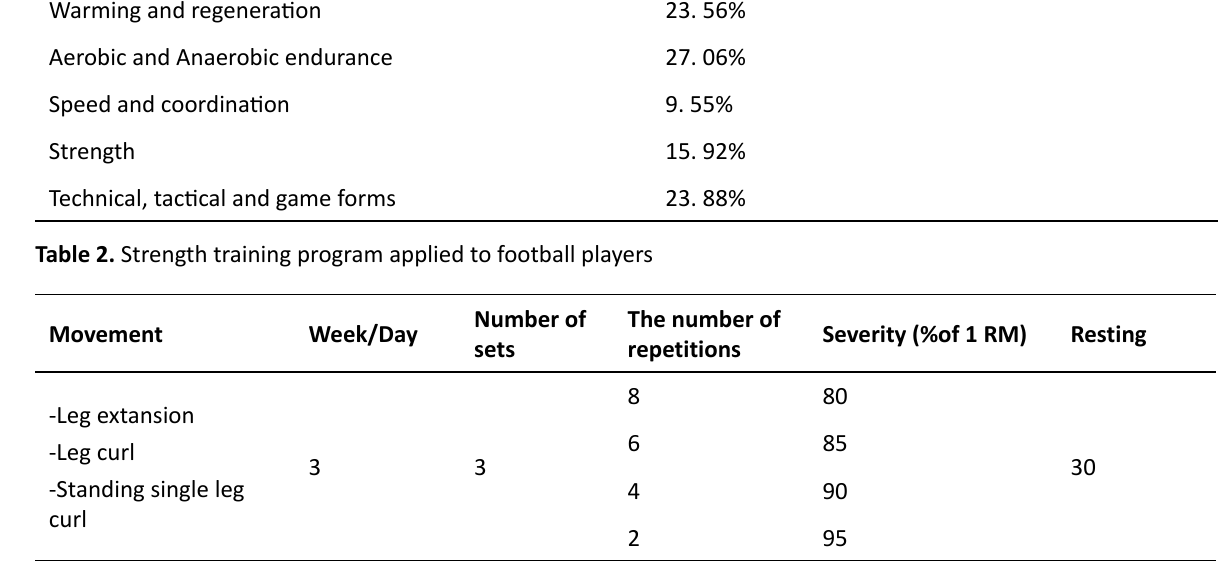
Table 1. Percentage distributions of football players based on the duration of team training for 8 weeks Training Type